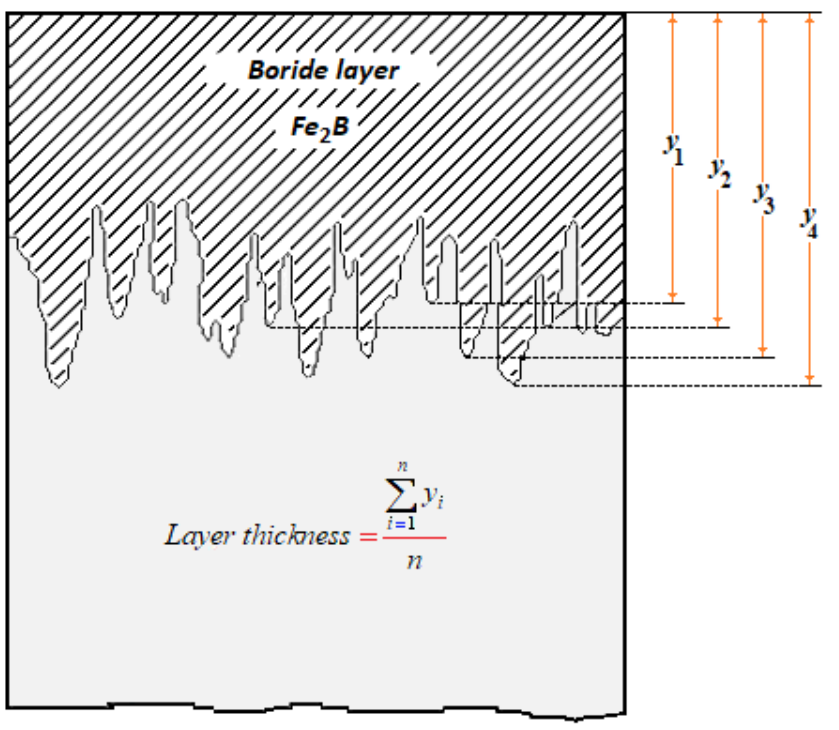
Figure 2. Method of measurement of layer thicknesses of Fe 2 B.